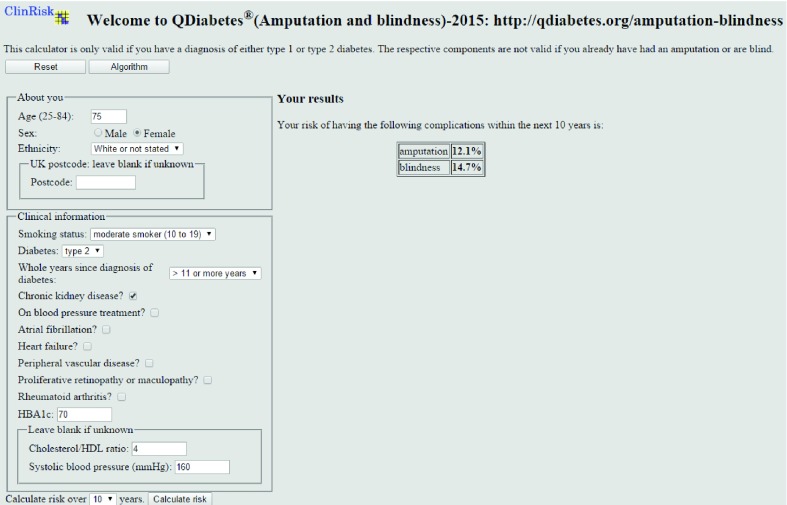
Fig 7 Web calculator applied to example male patient